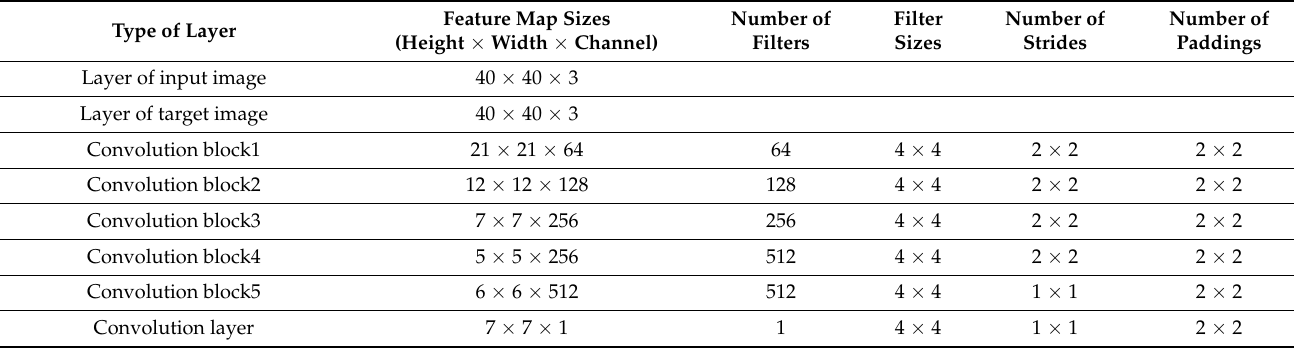
Table 4. Local discriminator of modified EnlightenGAN (convolution blocks through 1~5 include one convolutional layer and one Leaky ReLU